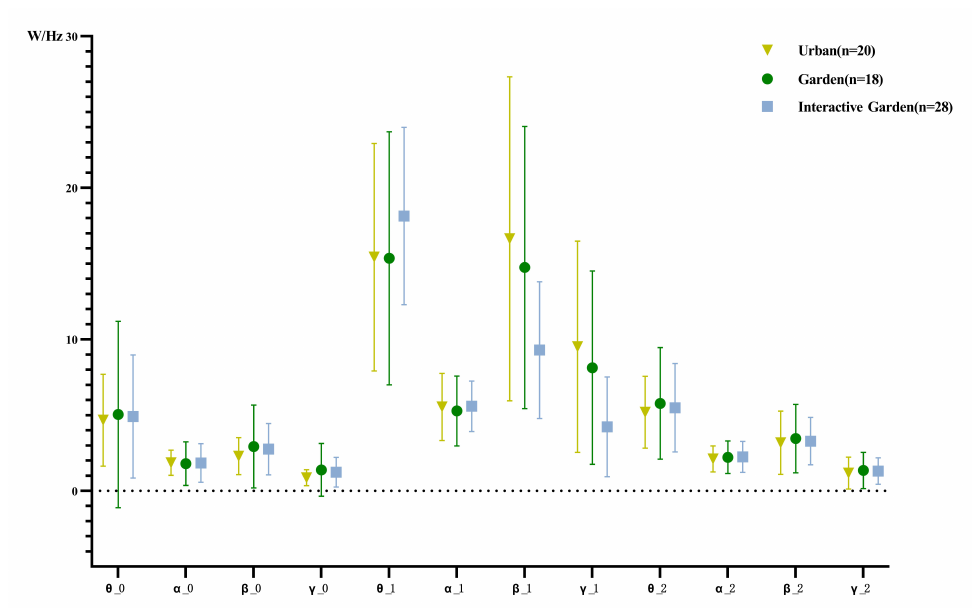
Figure 9. Descriptive statistical results 1 of PSD in different frequency bands.